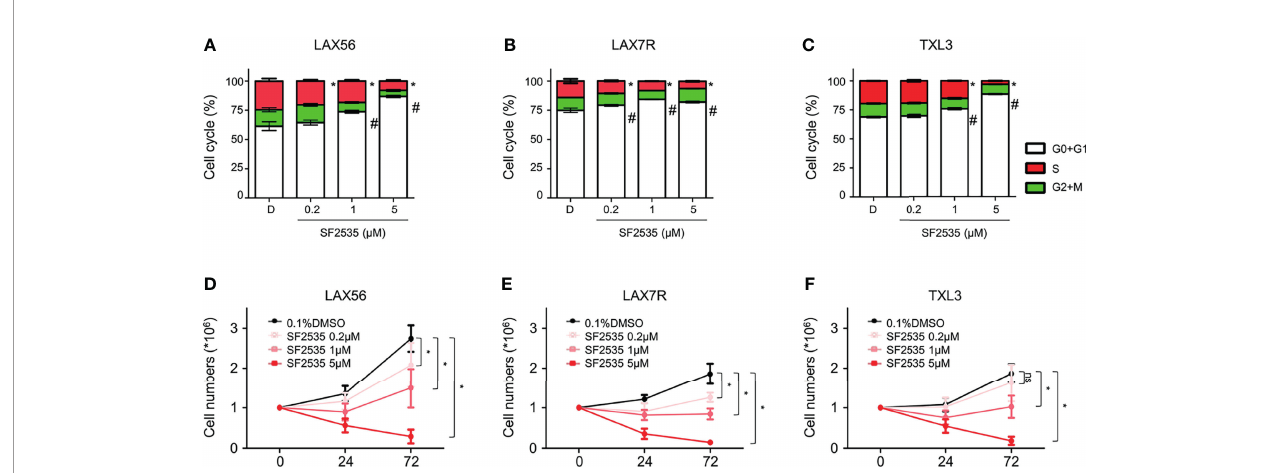
FIGURE 3 | SF2535 prolongs G0+G1 phase arrest and attenuates S phase. (A) LAX56, (B) LAX7R and (C) TXL3 B-ALL cells were treatment with DMSO or SF2535 (0.2 m M, 1 m M, or 5 m M) for 24 hours. Cell cycle was assessed via fl ow cytometry after 24 hours of treatment. White bars indicate G0+G1 Phase. Green bars indicate G2+M Phase. Red bars indicate the S Phase. P-value *<0.05: Comparing S phase compared to DMSO S phase. P-value # <0.05: Comparing G0+G1 phase to DMSO G0+G1 phase. The results are representative of two independent triplicate experiments. To determine the effect of SF2535 on proliferation and cell numbers, LAX56 (D) , LAX7R (E) and TXL3 (F) B-ALL cells were treated with DMSO or SF2535 (0.2 m M, 1 m M, or 5 m M) for 24 and 72 hours. Numbers of live cells were counted by Trypan blue exclusion on a hemocytometer. Data of three independent triplicate experiments in triplicates are combined. P-value *<0.05 compared to DMSO; ns, not signi fi